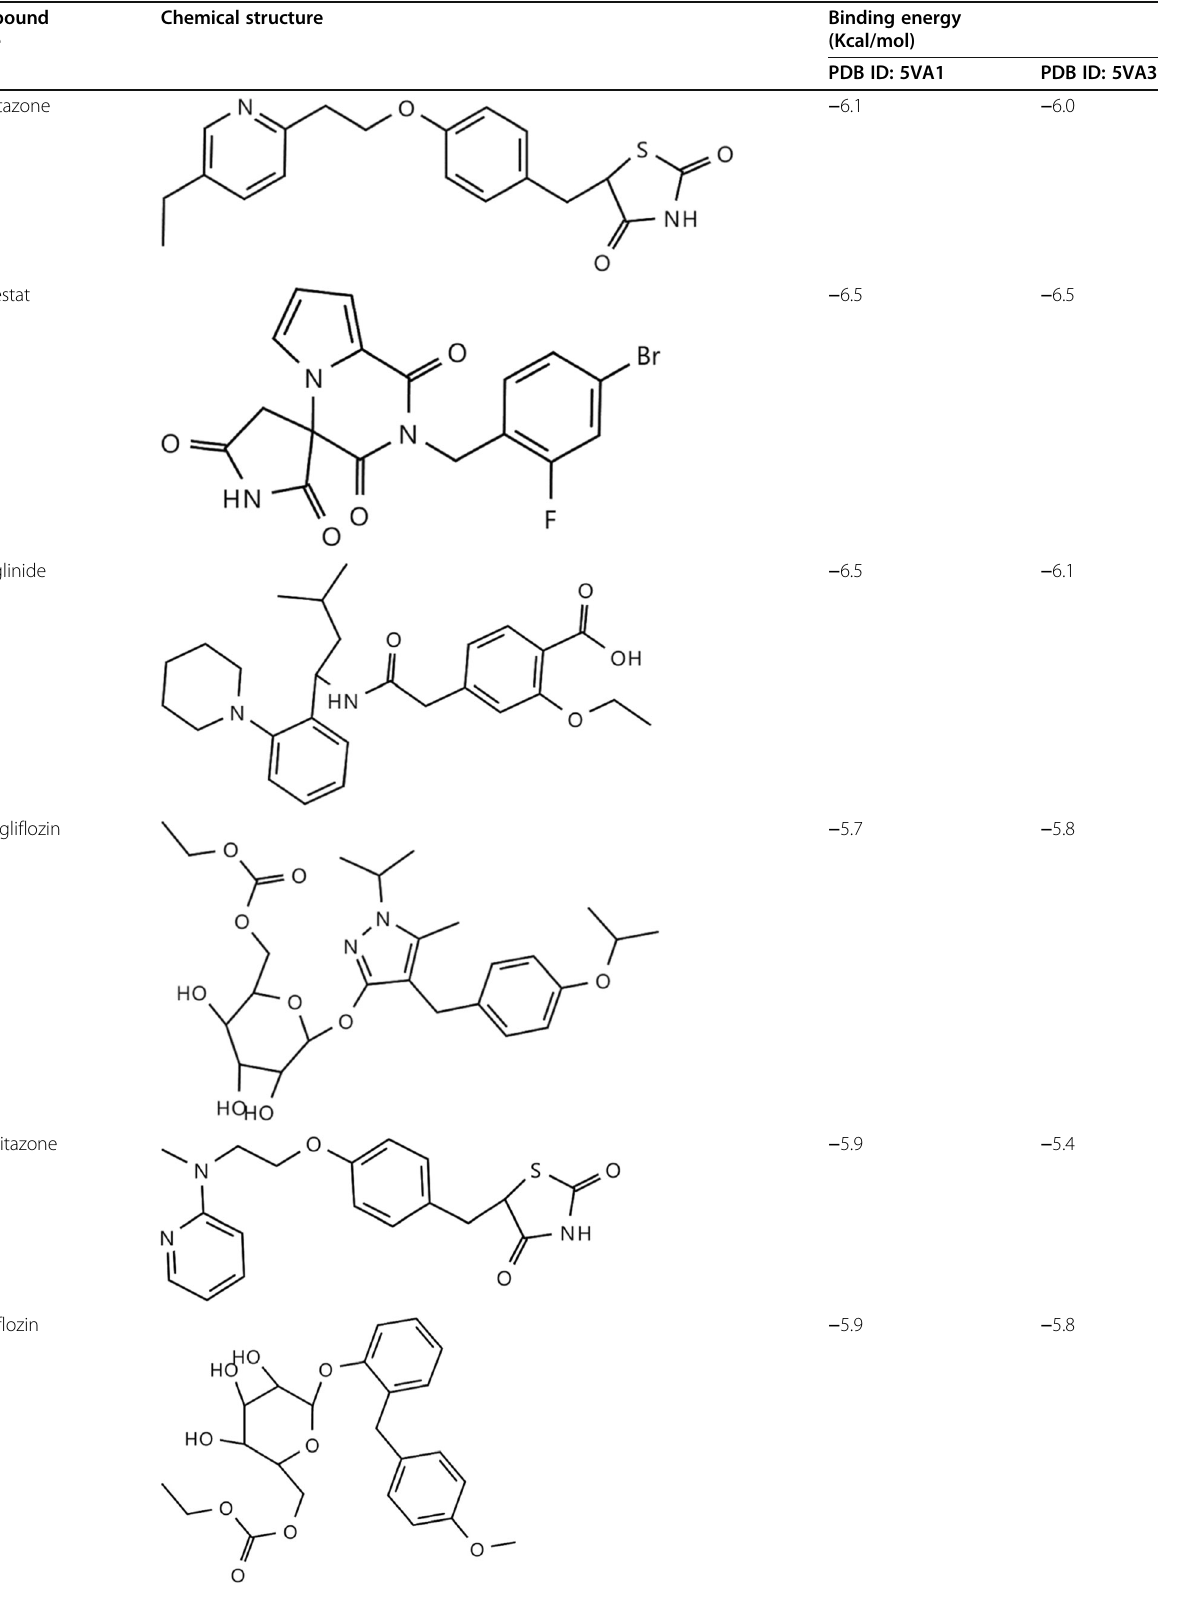
Table 2 The binding energies of the inhibitors with the two receptors (PDB IDs: 5VA1 and 5VA3)